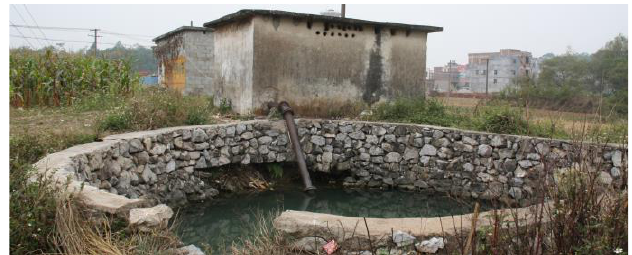
Figure 6. A typical groundwater mining well.